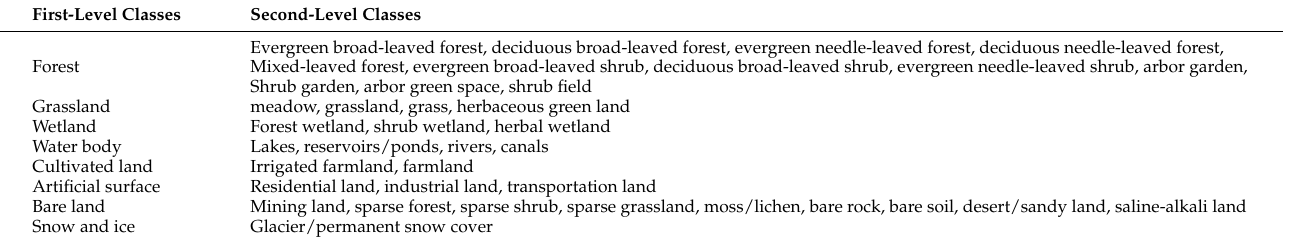
Table 1. Relationship between the proposed 8 first-level classes and the 38 second-level classes in the reference. First-Level Classes